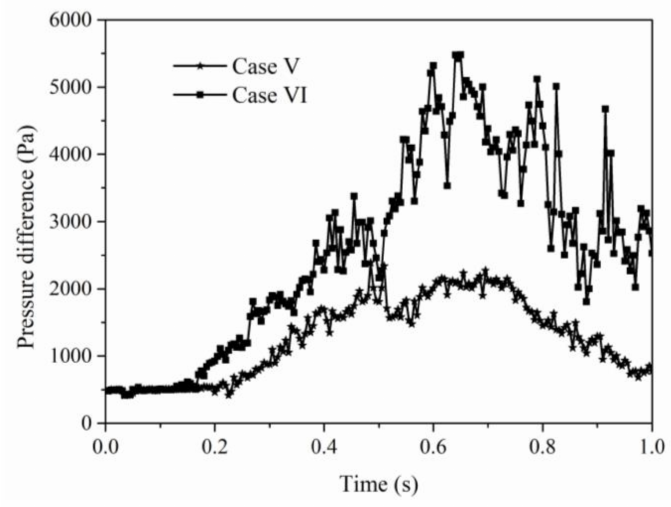
Figure 14. Variation of inlet–outlet pressure difference with time in cases V (slug injection) and VI (slug